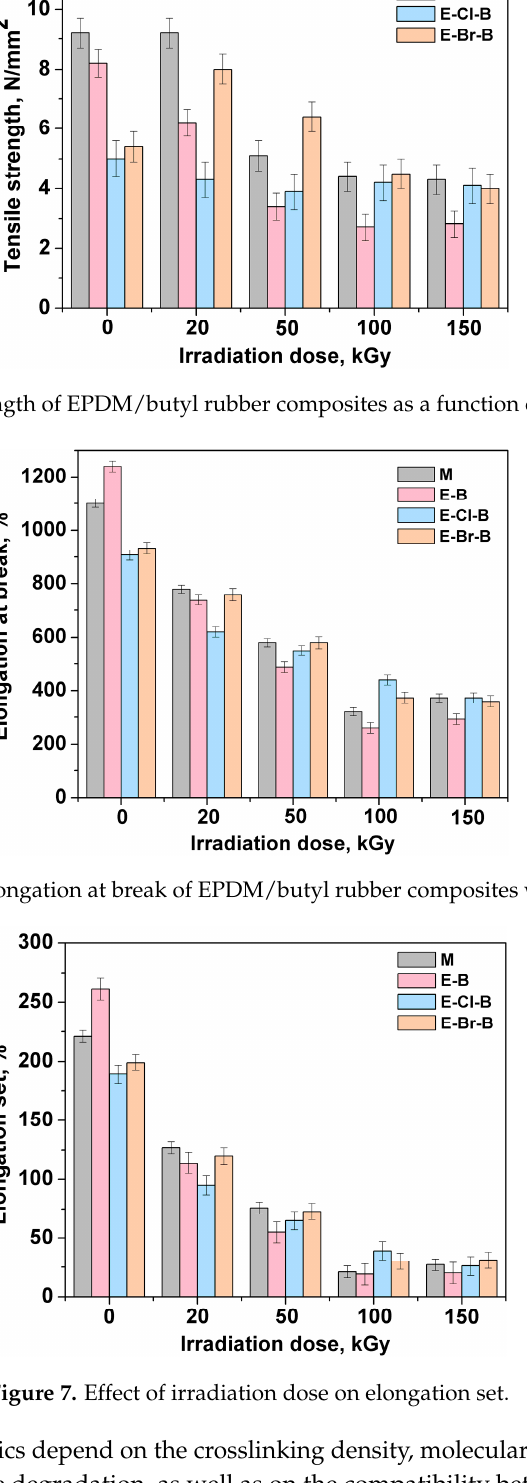
Polymers 2018 , 10 , x FOR PEER REVIEW 6 of 21 Figure 3. Variation of 100% modulus with electron beam irradiation dose.